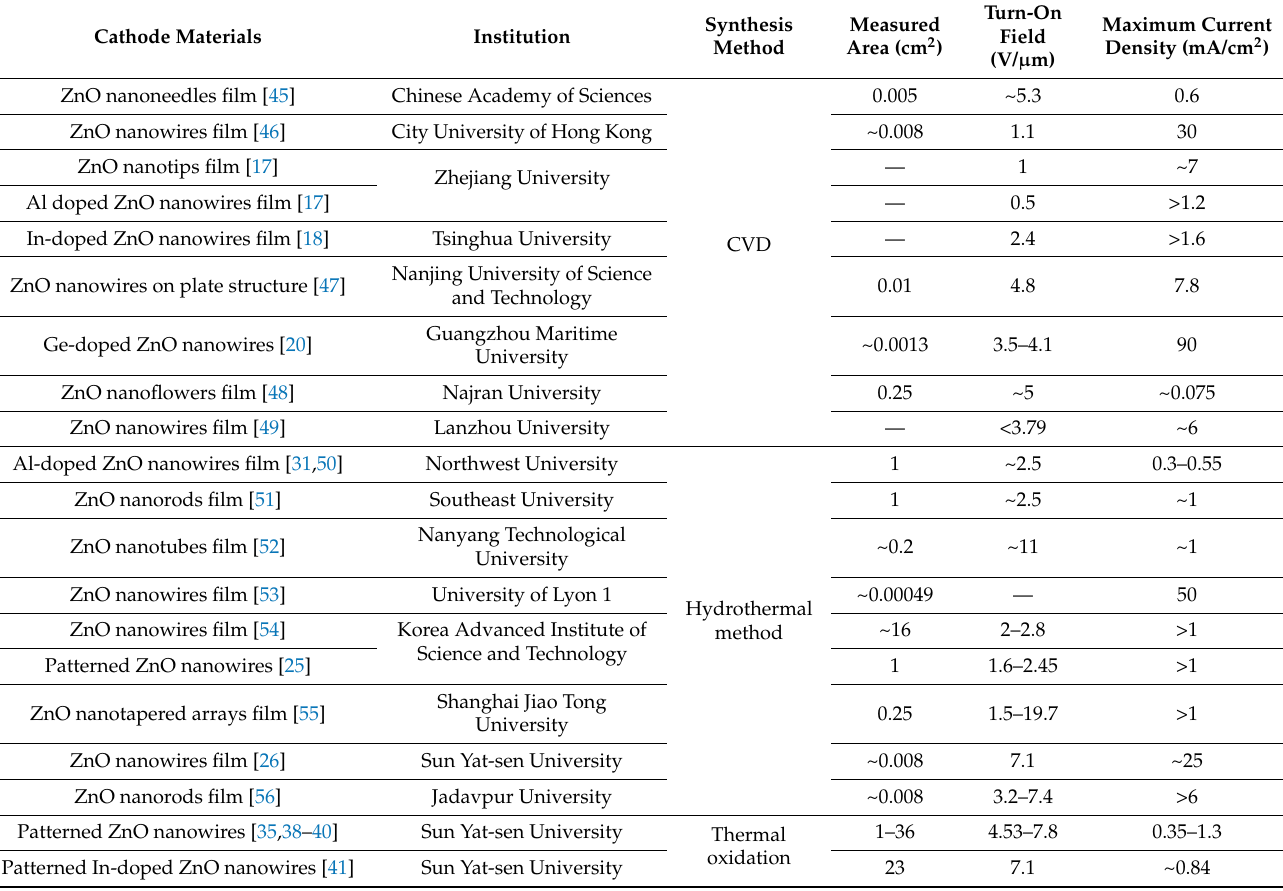
Figure 6. Relationships of field emission current ( a ) and current density ( b ) versus emission area plotted by reported works. The insets are the same results in linear coordinates. Reproduced from [40], with the permission of Elsevier, 2019. Table 1. Summary for recent works on the field emission properties from ZnO nanowires film. The turn-on field is defined as the applied field needed to obtain the emission current density of 10 µ A/cm 2 . “—” means the corresponding value is not provided in the reference. CVD is short for chemical vapor